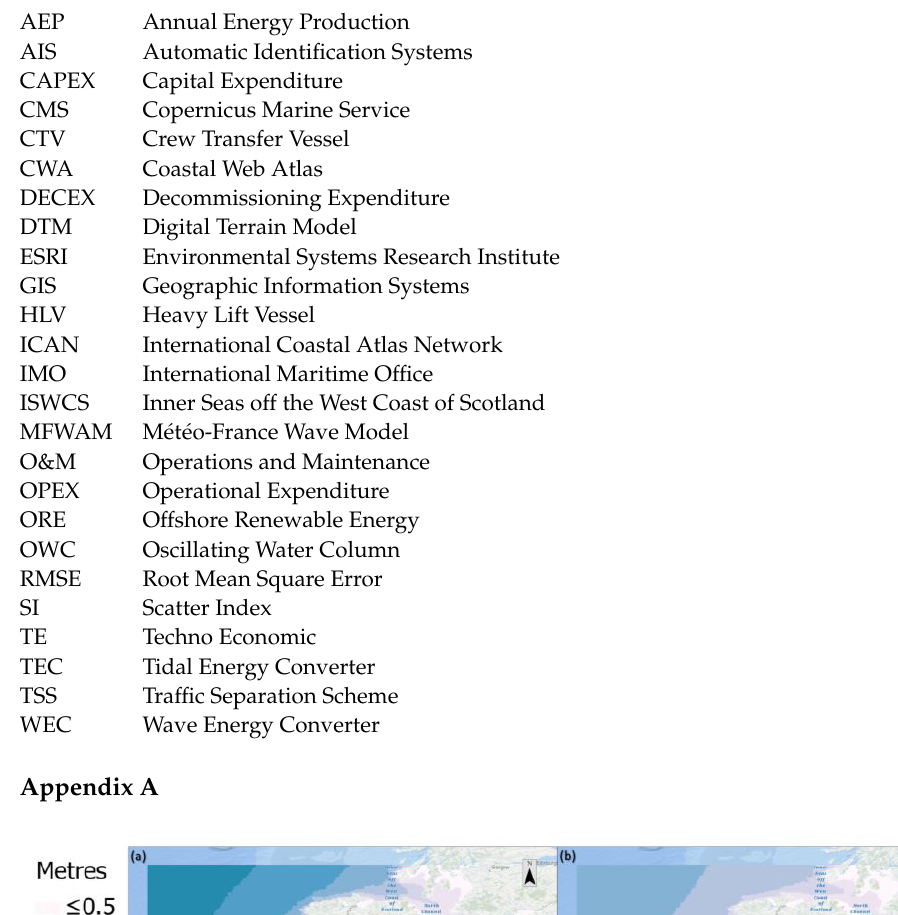
Figure A2. The seasonal mean wave period (T) in seconds for ( a ) spring, ( b ) summer, ( c ) autumn and ( d ) winter.